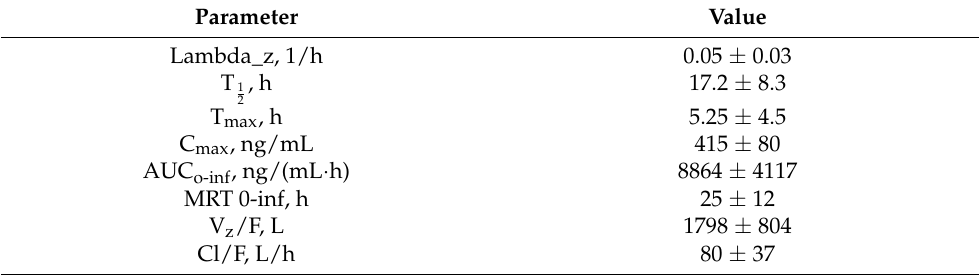
Table 5. Pharmacokinetic parameters of NIOCH-14, as calculated from data on its main immediate metabolite,